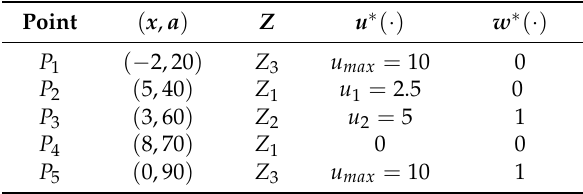
Table 4. Implementation of the control policy.